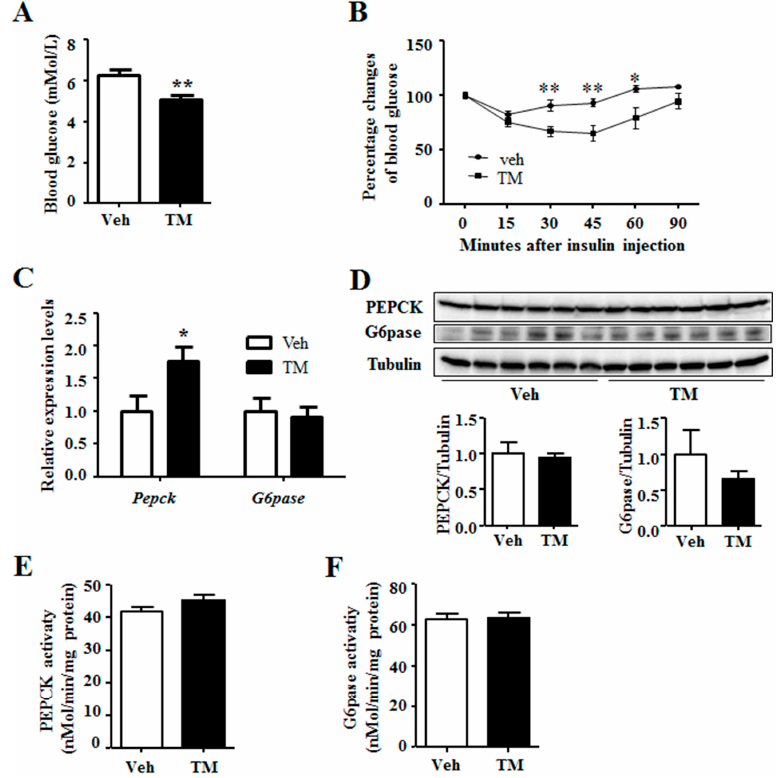
Figure 2. Tunicamycin reduced blood glucose level. ( A ) Blood glucose levels under fed state; N = 6 per group; ( B ) Insulin tolerance test. N = 7 per group; ( C ) Expression of gluconeogenic genes. N = 6 per group; ( D ) Western blotting bands and quantification for liver proteins; ( E ) The enzyme activity of PEPCK; ( F ) The enzyme activity of G6pase. Veh, vehcle; TM, tunicamycin. * p < 0.05, ** p < 0.01 TM vs. Veh.